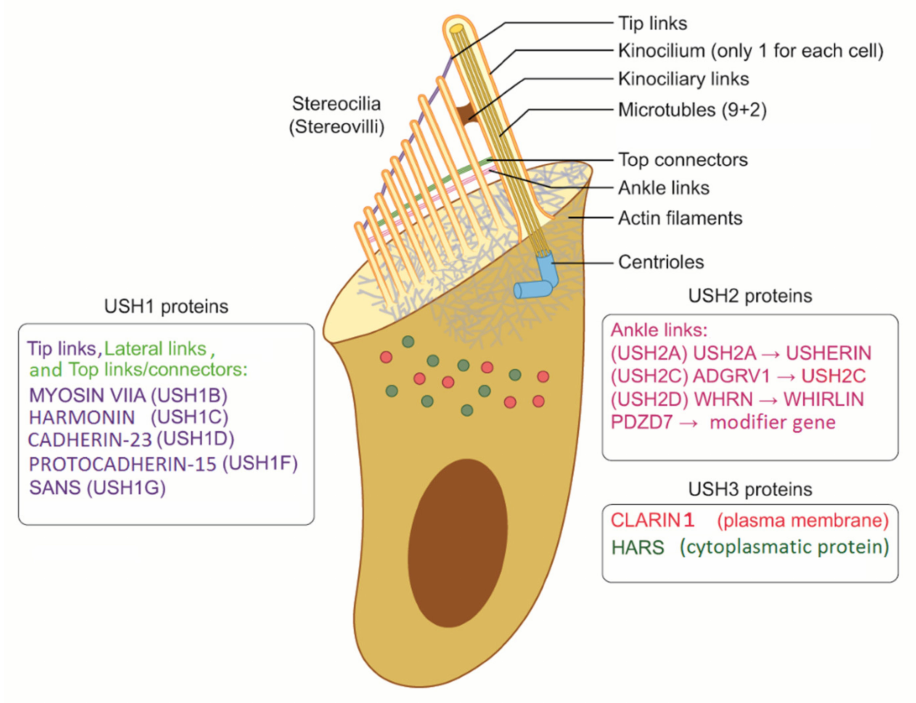
Figure 1. Schematic and simplified representation of a sensorineural cell in the inner